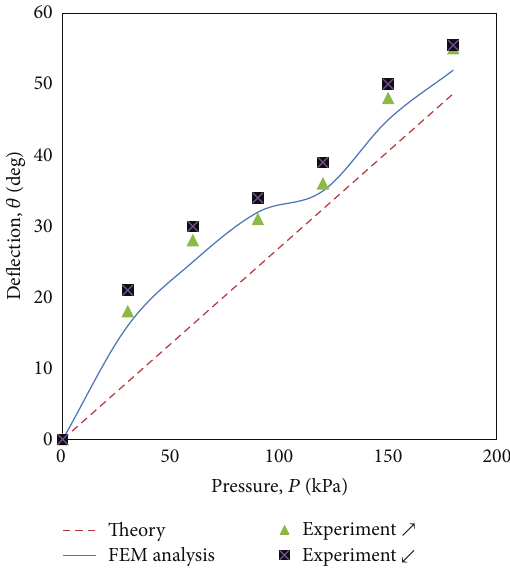
Figure 17: The static bending characteristics of AFPA.